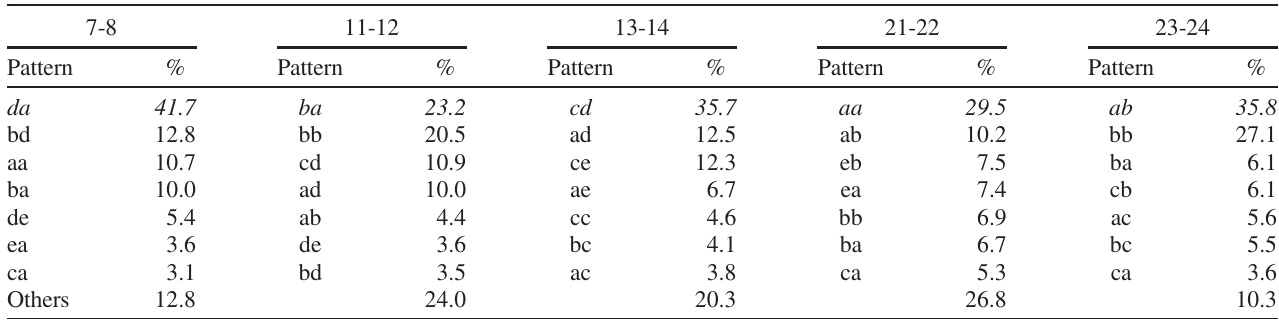
TABLE V. The most common answer patterns for questions with high inconsistency. The population is U.S. college freshmen students ( N ¼ 1576 ). The numbers reflect the percentage of the corresponding patterns. The patterns are ordered based on their popularity. The correct answer patterns are italicized, which happen to be the most popular answers for all question pairs.